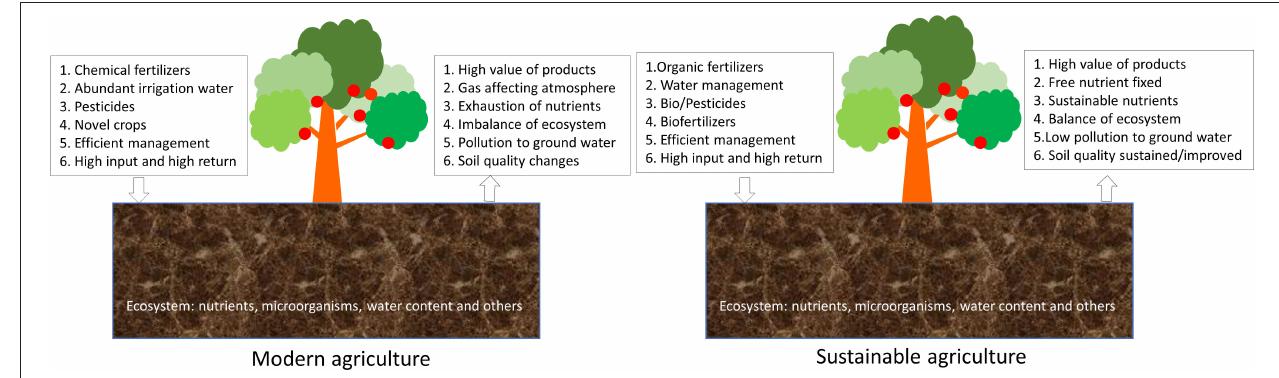
FIGURE 1 | Modern agriculture and sustainable agriculture. The difference of these two types of agriculture is